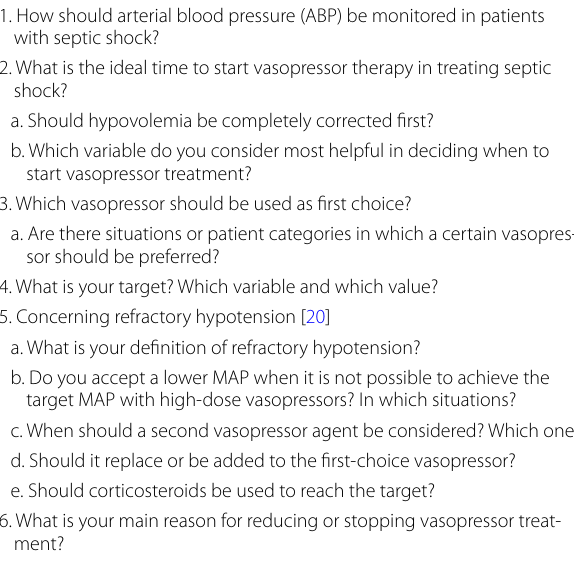
Table 3 Questions to experts on vasopressor